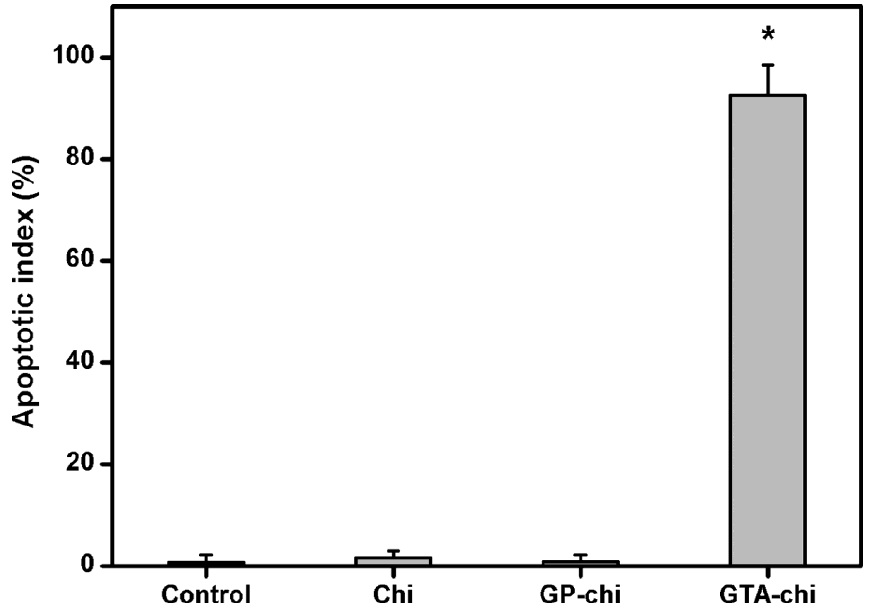
Figure 9. Apoptotic index of ARPE-19 cells exposed to various indicated chitosan membranes (5 mg) as determined by the TUNEL assay. An asterisk indicates statistically significant differences (* p < 0.05; n = 3) as compared to controls (without